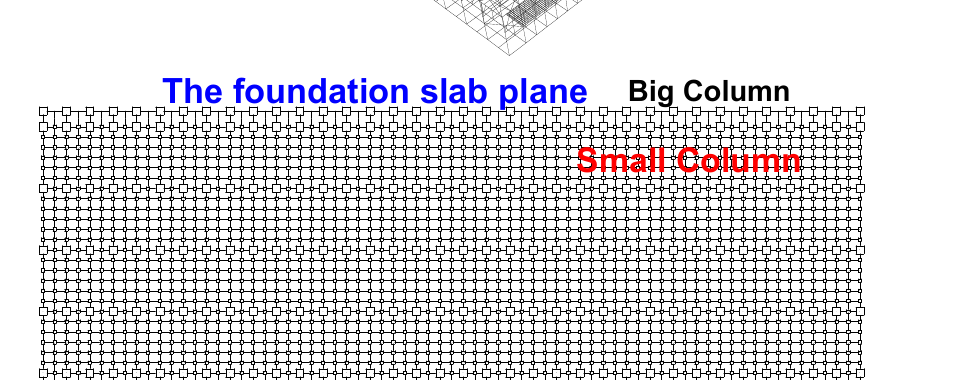
Figure 4. Three-dimensional (3D) Finite element mesh containing the high-tech factory, slabs, rails, and crane (The big and small columns are connected to LRB1 and LRBs, respectively, as shown in Table